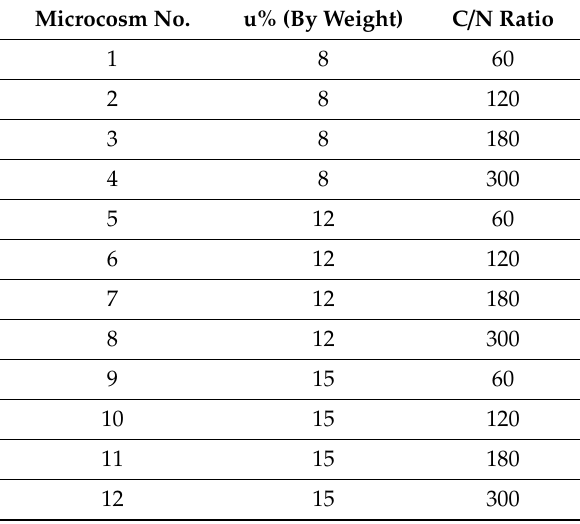
Table 3. Microcosms for experimental